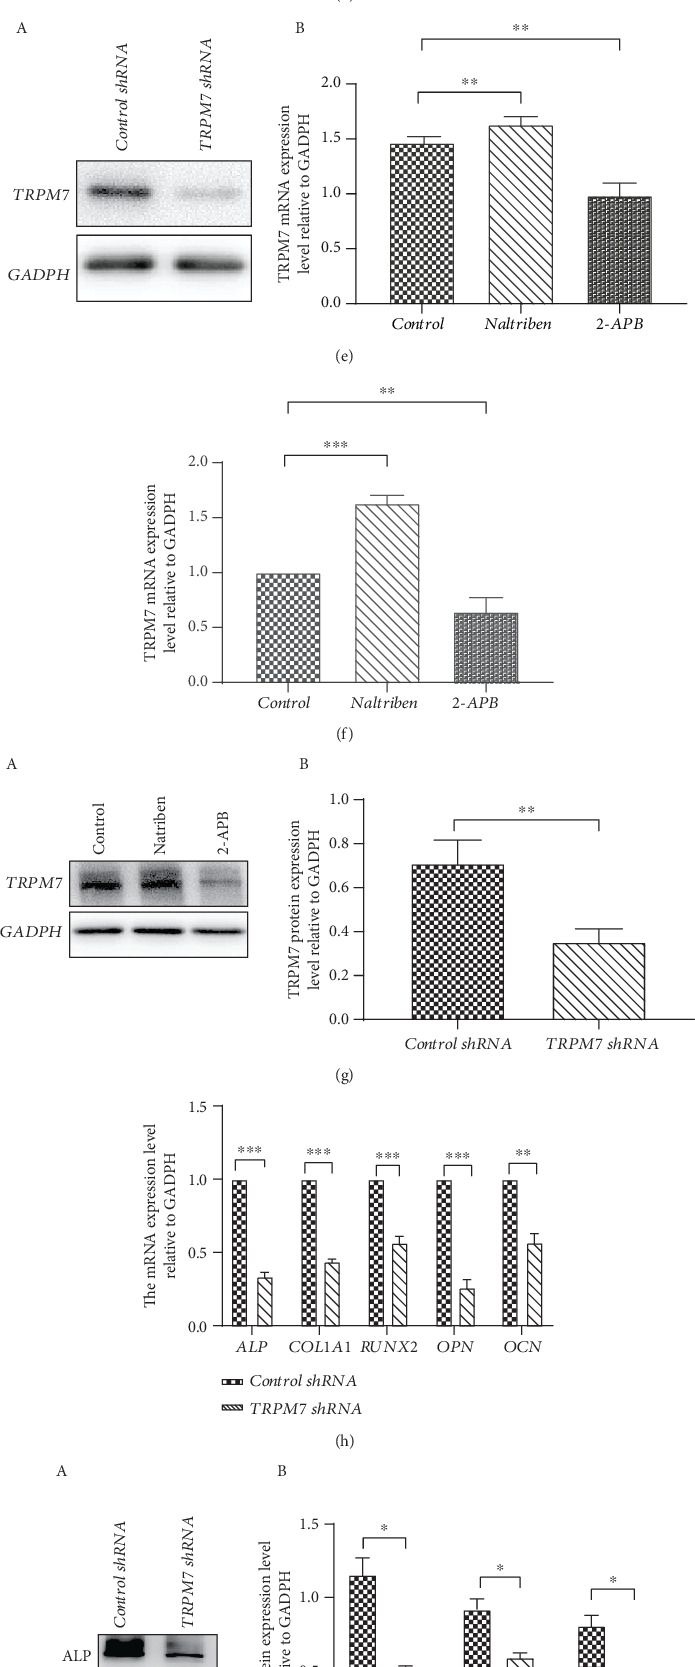
The effects of TRPM7 on the expression of osteogenic markers. (a) The expression of TRPM7 mRNA in cells induced for 0, 3, 7, and 14 days. (b) (A) The expression of TRPM7 protein in cells induced for 0, 3, 7, and 14 days. (B) Relative expression levels of TRPM7 protein were quantified and plotted. (c) (A) The expression of TRPM7 protein in cells noninduced for 0, 3, 7, and 14 days. (B) Relative expression levels of TRPM7 protein were quantified and plotted. (d) The expression of TRPM7 mRNA in cells treated with TRPM7 shRNA and control shRNA induced for 14 days. (e) The expression of TRPM7 protein in cells treated with TRPM7 shRNA and control shRNA induced for 14 days. The relative expression levels of TRPM7 protein were quantified and plotted. (f) The expression of TRPM7 mRNA in cells induced with the osteogenic medium or the osteogenic medium supplemented with Naltriben or 2-APB induced for 14 days. (g) (A) Western blot analysis of TRPM7 protein in cells induced with the osteogenic medium or the osteogenic medium supplemented with Naltriben or 2-APB. (B) The relative expression levels of TRPM7 protein were quantified and plotted. (h) The expression of osteogenic markers ALP, COL1A1, RUNX2, OPN, and OCN in cells treated with TRPM7 shRNA and control shRNA induced for 14 days. (i) (A)Western blot analysis of osteogenic marker proteins ALP, COL1A1, and RUNX2 in cells treated with TRPM7 shRNA and control shRNA. (B) Relative protein expression levels of osteogenic markers were quantified and plotted. (j) The expression of osteogenic markers ALP, COL1A1, RUNX2, OPN, and OCN in cells induced with osteogenic medium or osteogenic medium supplemented with Naltriben or 2-APB induced for 14 days. (k) (A) Western blot analysis of osteogenic marker proteins ALP, COL1A1, and RUNX2 in cells induced with osteogenic medium or osteogenic medium supplemented with Naltriben or 2-APB. (B) Relative protein expression levels of osteogenic markers were quantified and plotted. TRPM7 shRNA: hBMSCs transfected with TRPM7-shRNA-vector; control shRNA: hBMSCs transfected with negative control-shRNA-vector; ∗P < 0.05, ∗∗P < 0.01, and ∗∗∗P < 0.0001.